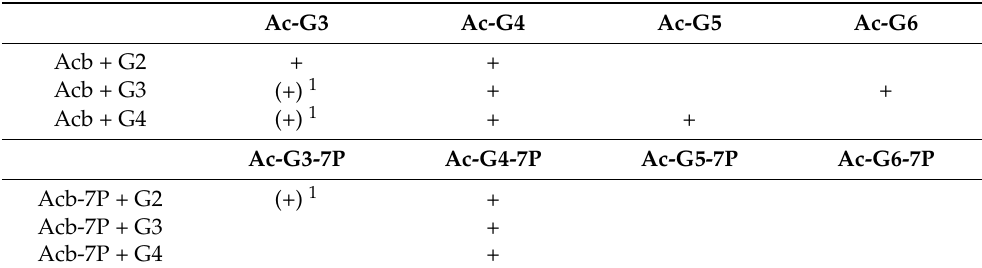
Figure 6. LC-ESI-MS analysis of AcbQ products. Reaction mixture was incubated with acarbose and maltotriose. ESI (+) EIC for acarbose m/z 646.2553 ( top chromatogram), ESI (+) EIC for acarviosyl- maltotetraose m/z 970.3609 ( middle chromatogram), ESI (+) EIC for acarviosyl-maltohexaose m/z 1294.4665 ( bottom chromatogram). Chromatograms contain the schematic illustration of the respec- tive acarviosyl metabolite. Legend to the illustrations is on top. Table 3. Overview of detected acarviosyl metabolites in AcbQ enzyme assays by LC-ESI-MS. Acarbose and acarbose 7-phosphate were combined with different α -1,4-glucans (G2, G3 or G4). Identified acarviosyl metabolites are marked with